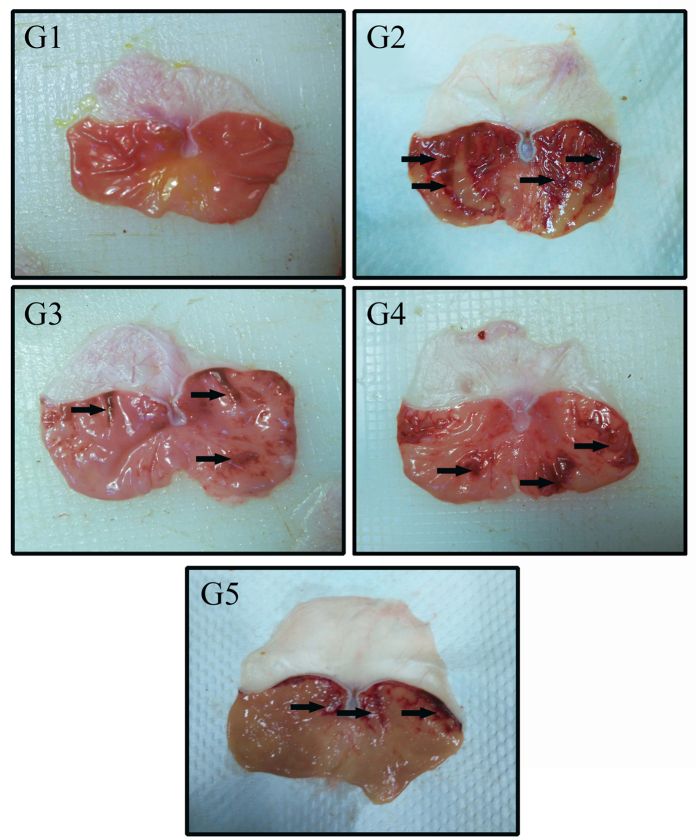
Macroscopic appearance of the gastric mucosa in HCl/Ethanol induced gastric ulcer in rats.(G1) Group 1 has no injury to the gastric mucosa. (G2) Group 2 have severe injuries in the gastric mucosa. HCl/Ethanol produced extensive visible hemorrhagic necrosis of the gastric mucosa. (G3) Rats in group 3 pretreated with omeprazole have mild injuries to the gastric mucosa, comparing to the injuries observed in group 2. (G4) Rats in group 4 have moderate injuries in the gastric mucosa. MDLA reduces the formation of gastric lesions induced by HCl/Ethanol. (G5) Rats in group 5 have mild injuries in the gastric mucosa. Black arrows show the location of the lesions inside the gastric mucosa.